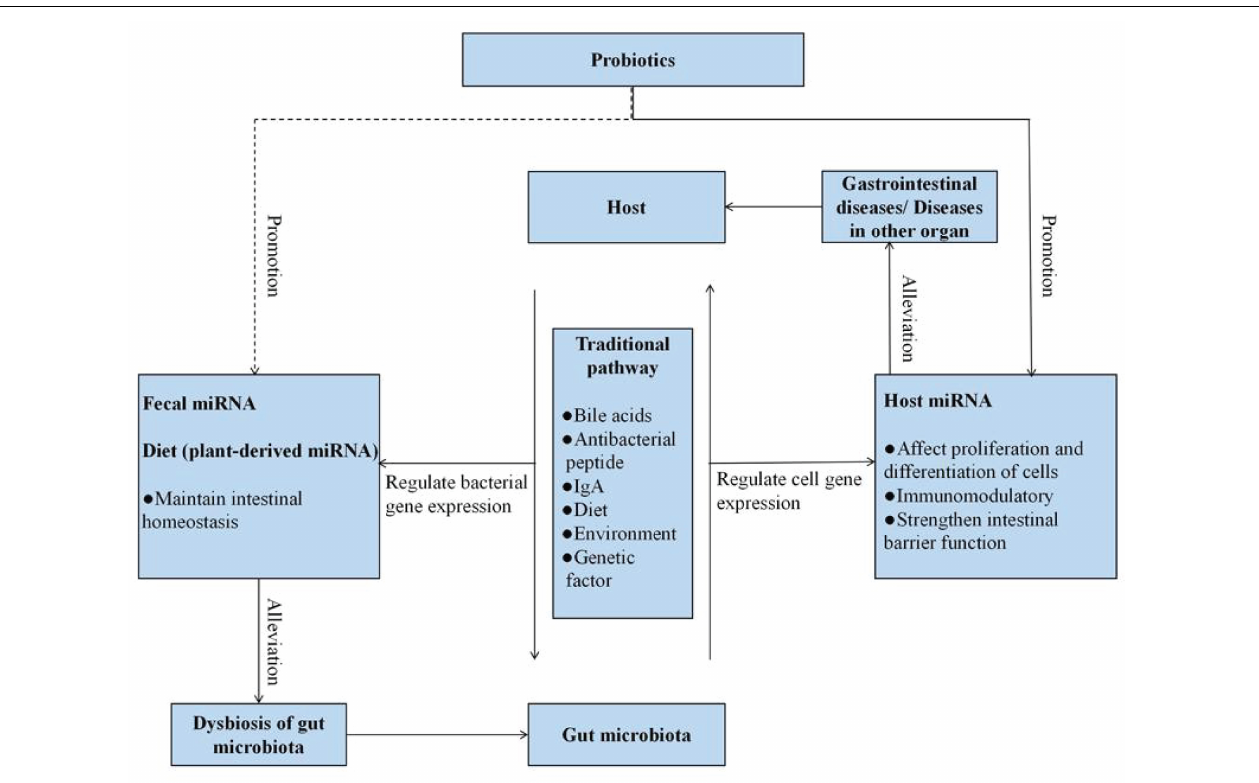
FIGURE 1 | Probiotics and miRNA, as well as their implications for host–microbe interactions. The traditional pathways involving in host–microbe interactions are mainly dominated by bile acids, antibacterial peptide, and IgA. In addition, the traditional pathways also include dietary, environmental, and genetic factors. Moreover, the host regulates bacterial gene expression via fecal miRNA and plant-derived miRNA to shape gut microbiota. Gut microbiota regulate cell gene expression via host miRNA to alleviate various gastrointestinal diseases. Probiotics have impacts on these host–microbe interactions. The dotted line represents the lack of conclusive evidence in the relationship at